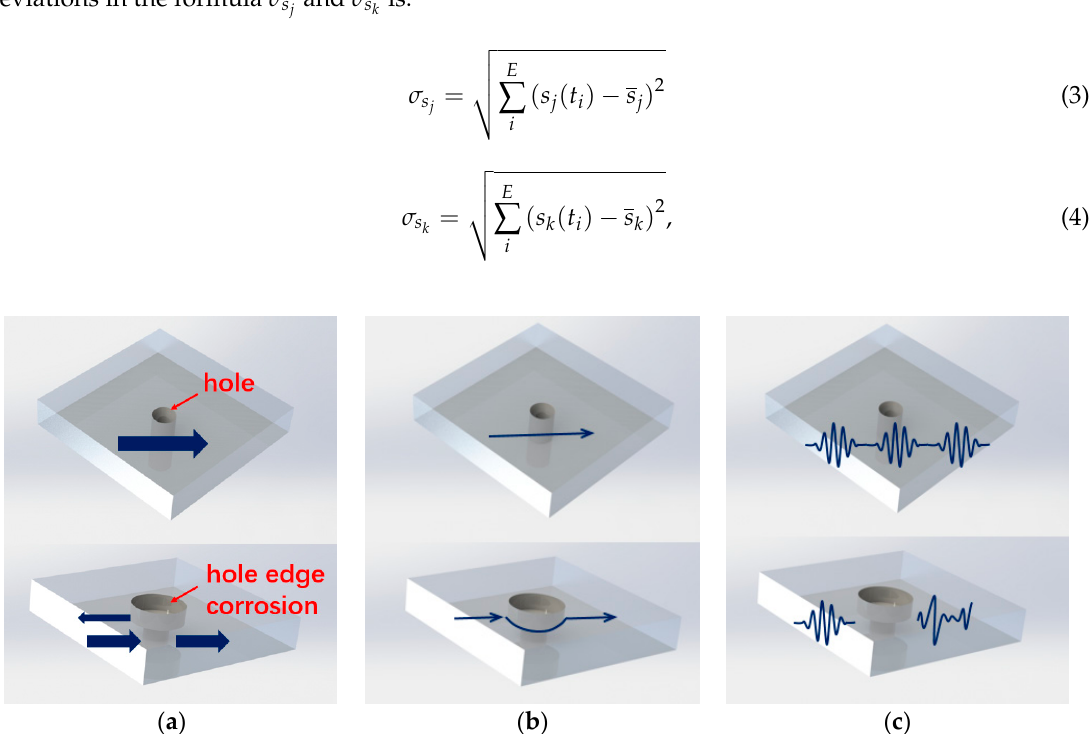
Figure 1. Dispersion curve for a smooth aluminum alloy plate with thickness of 2 mm.